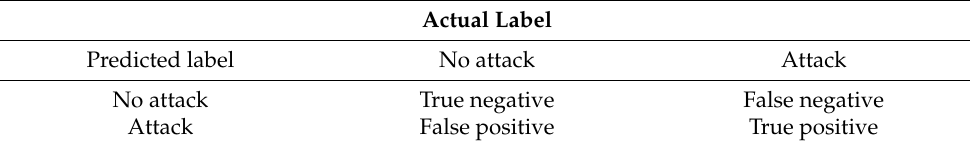
Table 2. Confusion matrix example.